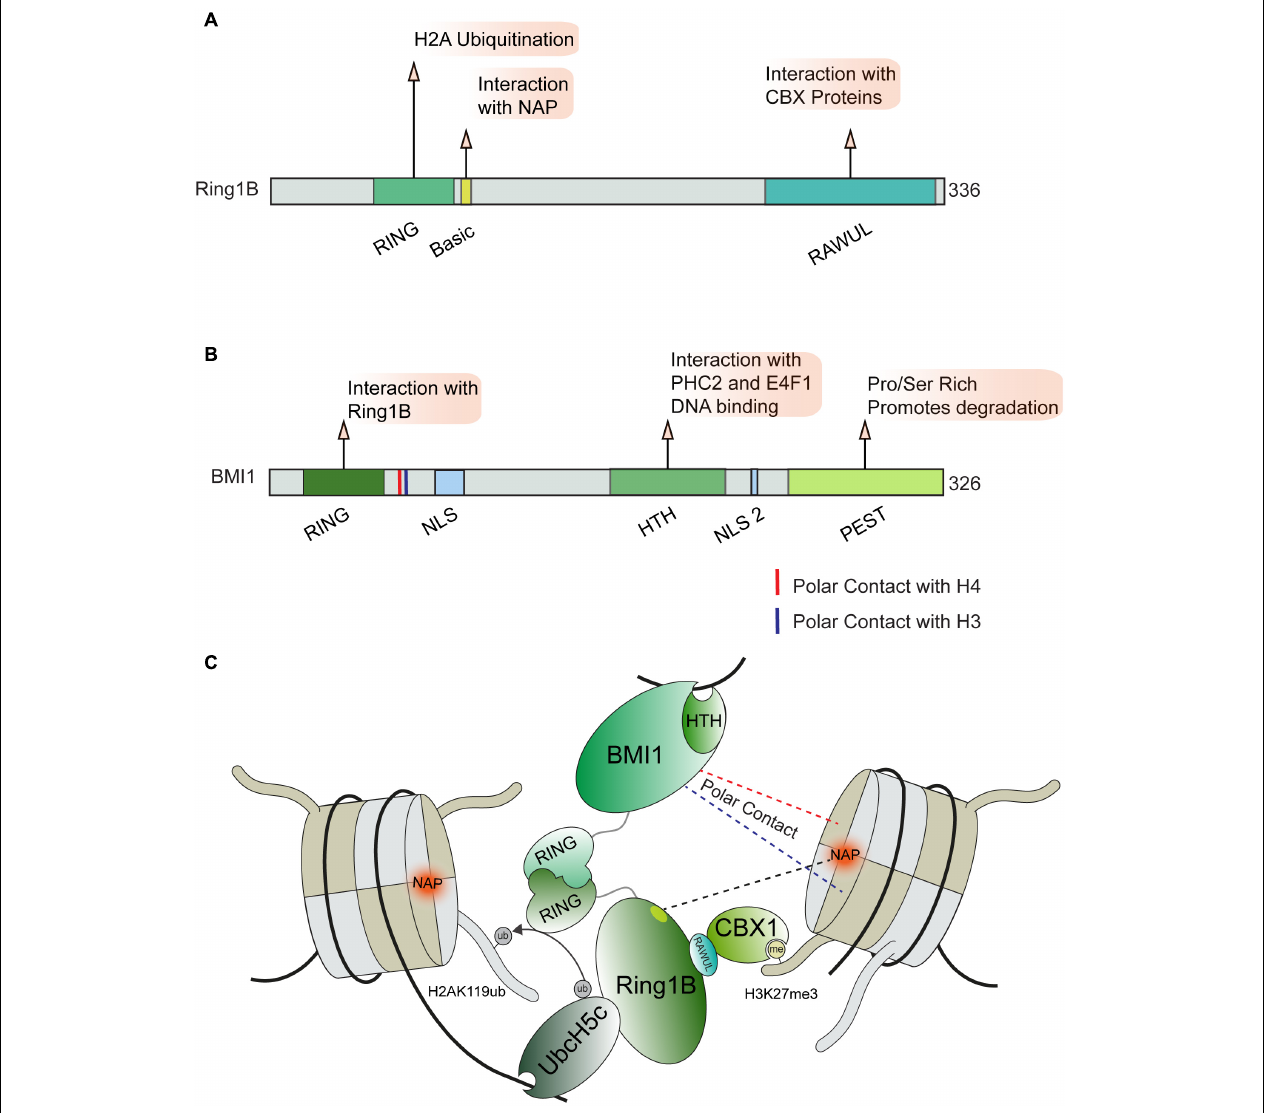
FIGURE 4 | PRC1 complex and chromatin interactions involved in DNA repair. (A) Ring1b and (B) BMI1 domain maps and DDR related interactions. (C) Depiction of chromatin interactions exhibited by core PRC1 members BMI1 and Ring1B involved in transcriptional repression and DNA repair. BMI1 and Ring1B associate via their RING domains, Ring1B directly interacts with CBX1 and the E2 enzyme Ubch5c which help position the PRC1 complex for ubiquitin conjugation on H2AK119. Polar contact between BMI1 and H3 or H4 are indicated by blue and red dotted lines, respectively. BMI1, B lymphoma Mo-MLV insertion region 1 homolog;